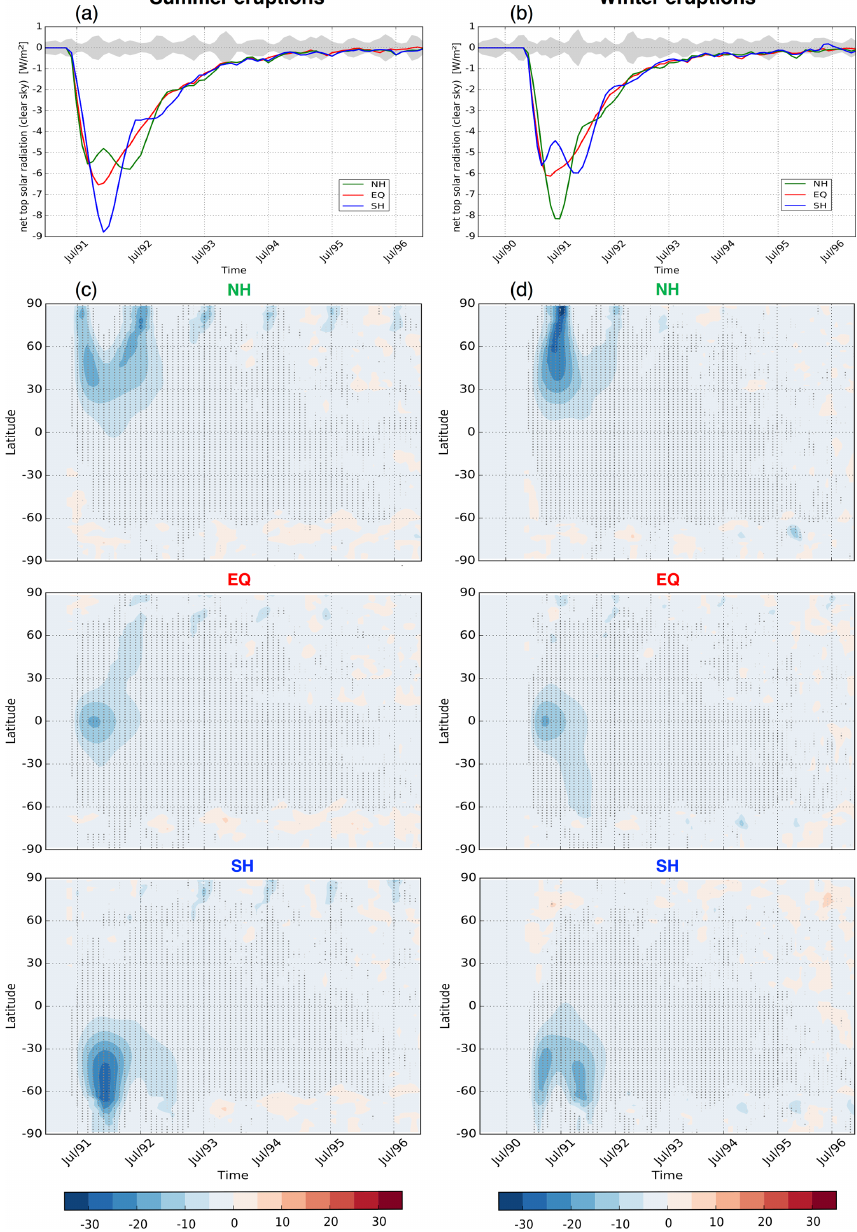
Figure 2. Global mean net outgoing solar radiation (Wm − 2 ) anomaly at the top of the atmosphere in clear-sky conditions for the summer (a) and winter (b) volcanic eruption cases and their zonal mean distributions (c, d) . The grey shading in (a) and (b) indicates 2 standard deviation of the control runs without any volcanic eruption. Dark grey and light grey stippling in (c) and (d) indicate the grid points with significant differences based on the two-tailed Student’s t test at the 95% and 99% confidence level,